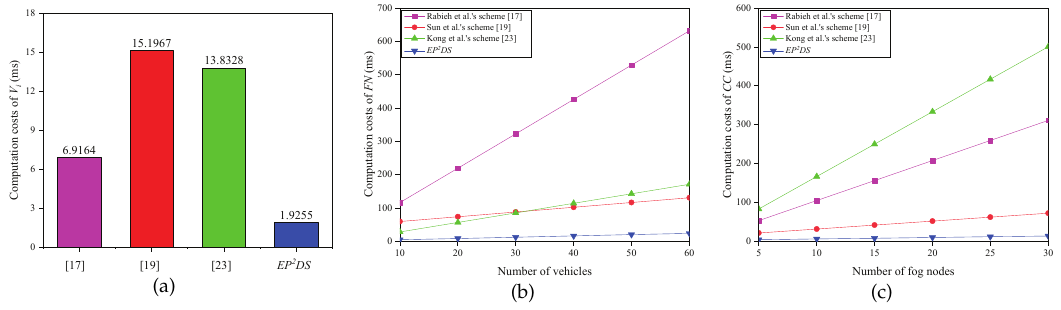
Figure 3. Computation costs in the data collection phase. ( a ) Computation costs of V i ; ( b ) Computation costs of FN vs. number of vehicles; ( c ) Computation costs of CC vs. number of FN .